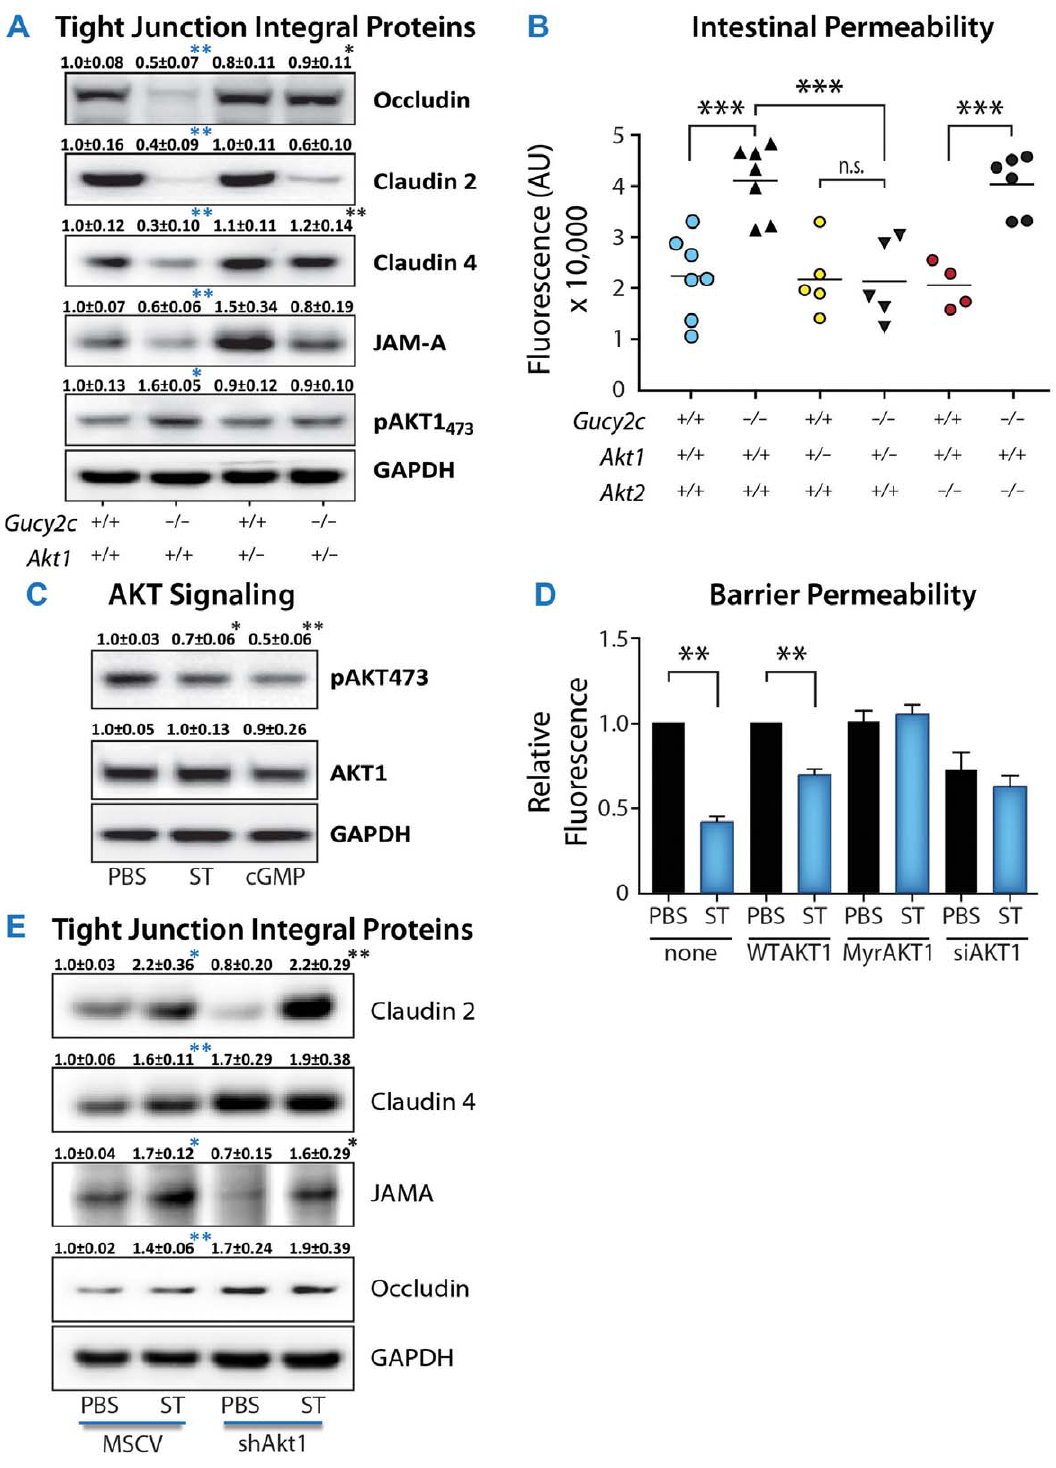
Figure 6. GUCY2C regulation of barrier integrity is AKT1-dependent. ( A ) Immunoblot analysis of tight junction proteins from jejuna of 12 week-old mice (n $ 7). Data represent means 6 SEM. Blue asterisks compare results to Gucy2c + / + , black asterisks compare results to Gucy2c 2 / . ( B ) Intestinal permeability was examined by serum fluorescence 90 min after FITC-dextran gavage. Each point represents one mouse. ( C ) Regulation of AKT phosphorylation by GUCY2C signaling in Caco2 human colon cancer cells was examined by immunoblot analysis. Data represent means 6 SEM of 3 experiments done in duplicate. ( D ) AKT1 signaling in Caco2 cells was manipulated by adenovirus-delivered AKT1 (WTAKT1), constitutive active AKT1 mutant (MyrAKT1), or siRNA against AKT1 (siAKT1). Two days after infection, cells were treated with ST for 6 d. Barrier permeability was examined by FITC-dextran diffusion. Data represent mean 6 SEM obtained from one of five experiments done in triplicate. ( E ) Tight junction protein expression was examined by immunoblot analysis in Caco2 cells stably expressing empty vector (MSCV) or shRNA against AKT1 (shAKT1) after 6 d of ST treatment. Data represent means 6 SEM of three experiments done in duplicate. Blue asterisks compare results to MSCV-PBS, black asterisks compare results to MSCV-ST. *, p , 0.05, **, p , 0.01, ***, p , 0.001. In C–E, statistical analyses were compared to PBS control. doi:10.1371/journal.pone.0031686.g006 PLoS ONE |